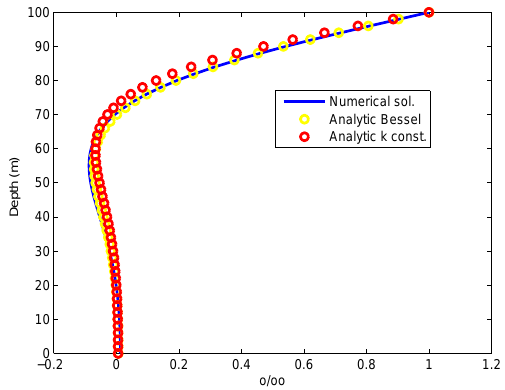
Figure 16. Comparison, for a 100m deep core of the numerical solution with k 0 = 10 − 9 , k 1 = 10 − 11 ms − 1 , and a 20000-year pe- riod, with the analytical solution (A2). The analytical solution with constant k = 10 − 9 m 2 s − 1 is also